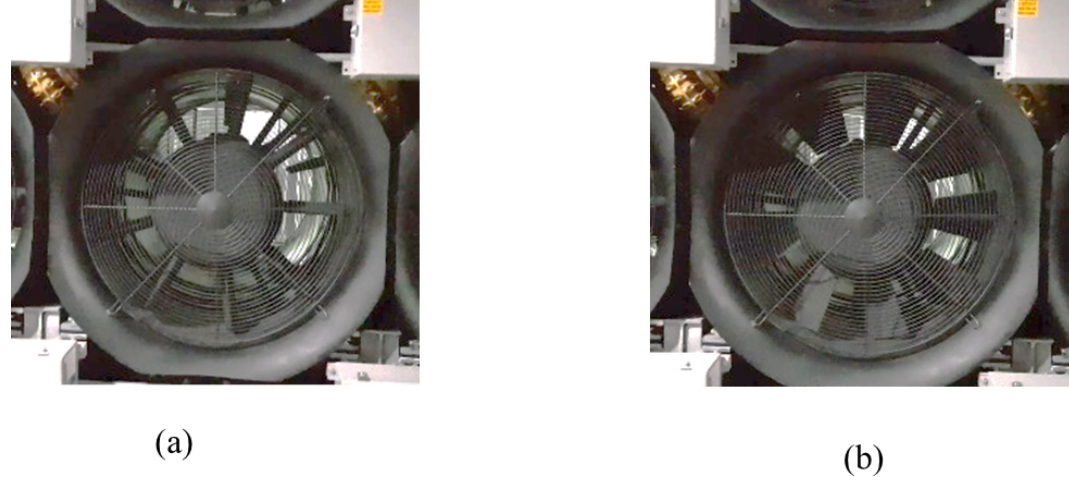
Figure 2. The adjustable vanes at the inlets of the 60-fan wall, (a) 100% open vanes and (b) 70% open